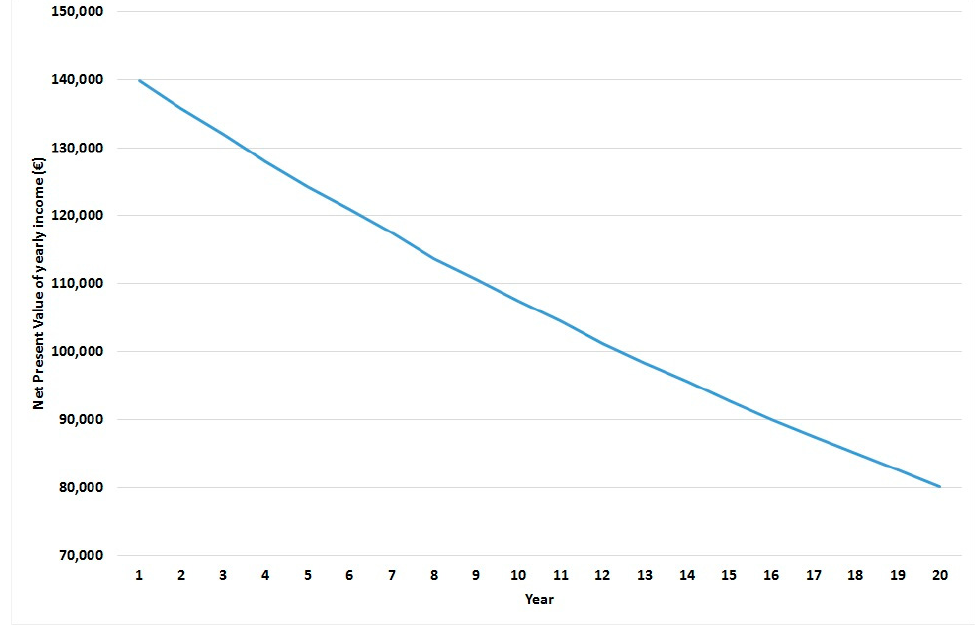
Figure A2. Income net present value for year and per MW of installed capacity.